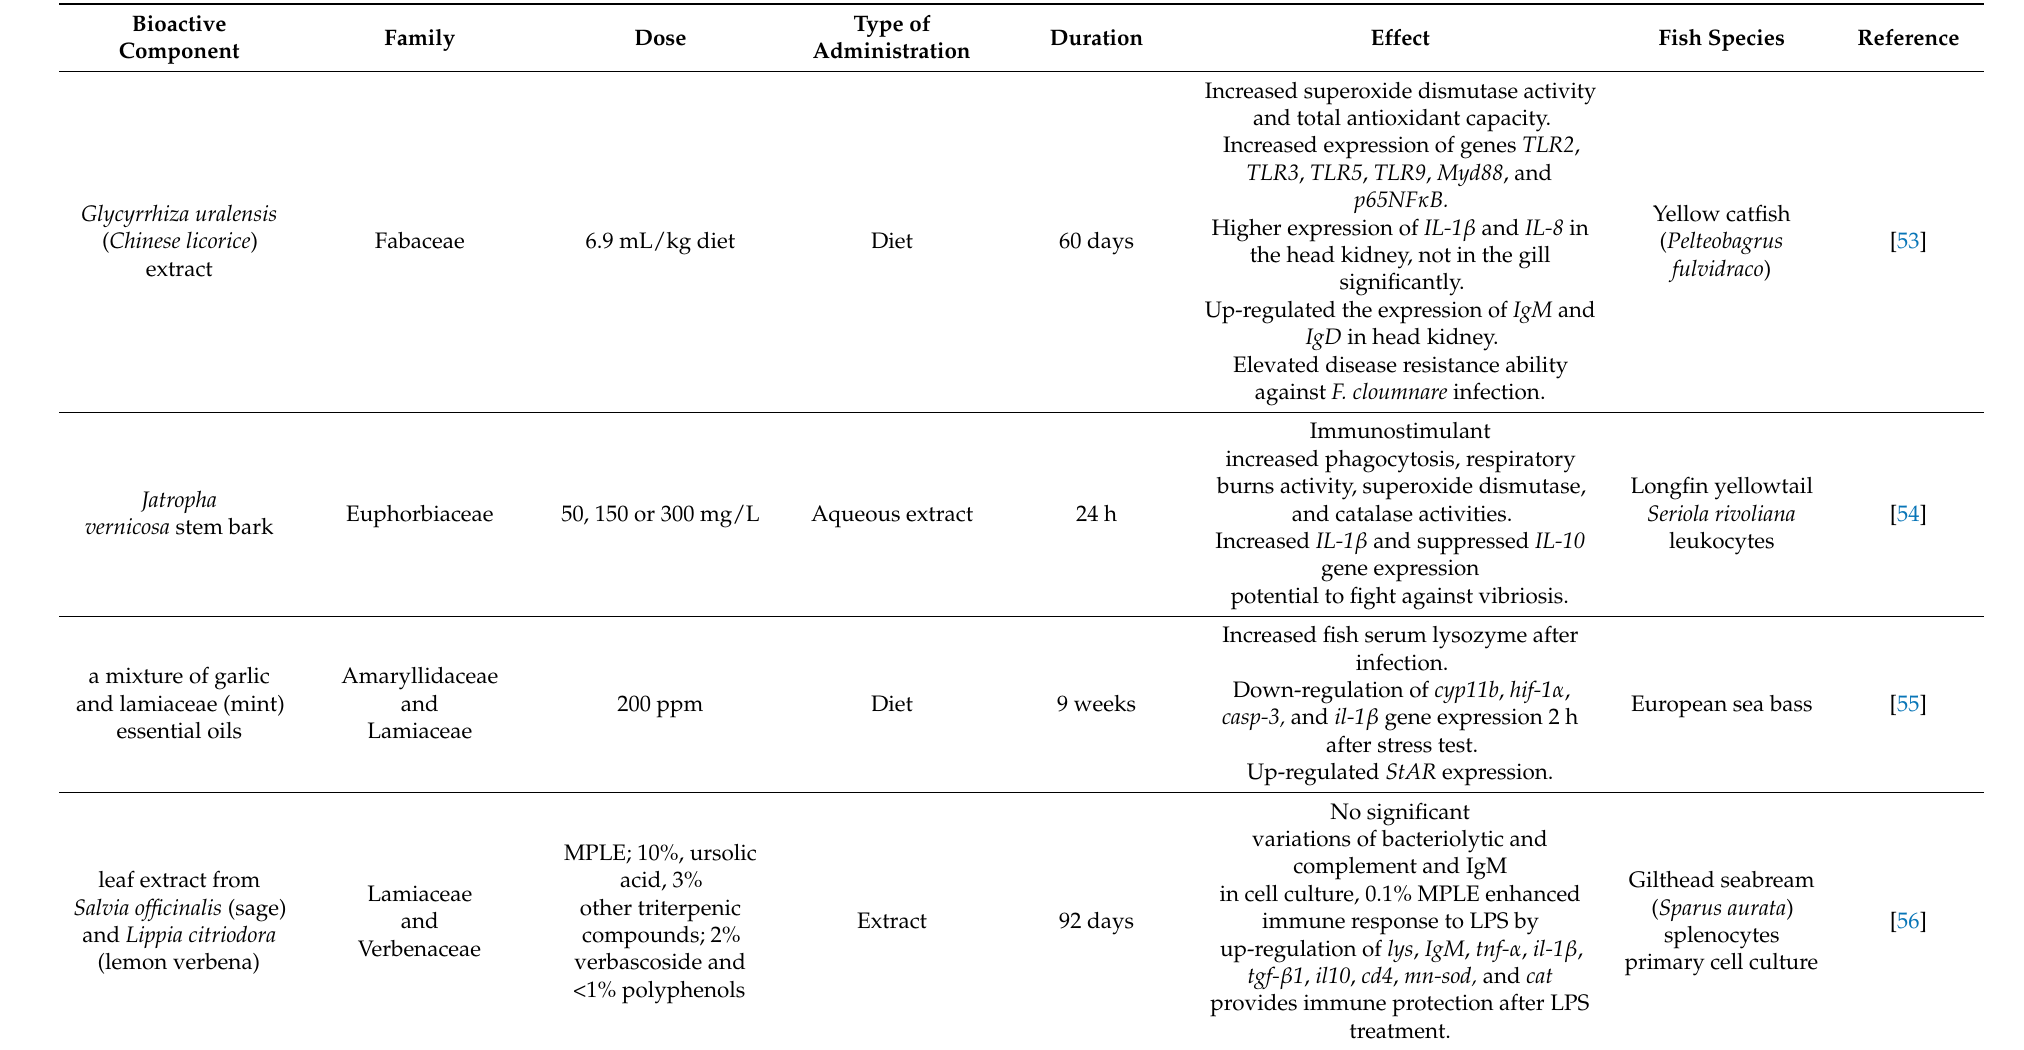
Table 2. Selected studies regarding the effects of herbal extracts and phytochemicals on immune-related